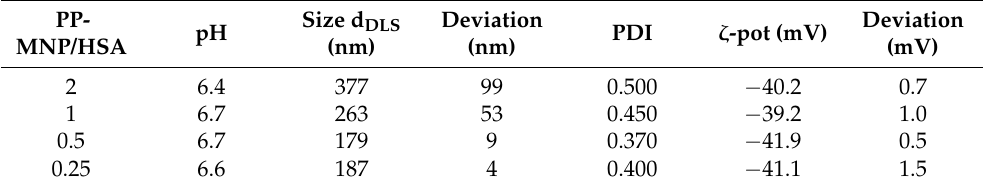
Table 4. DLS/ELS data for the titration of PP-MNPs with